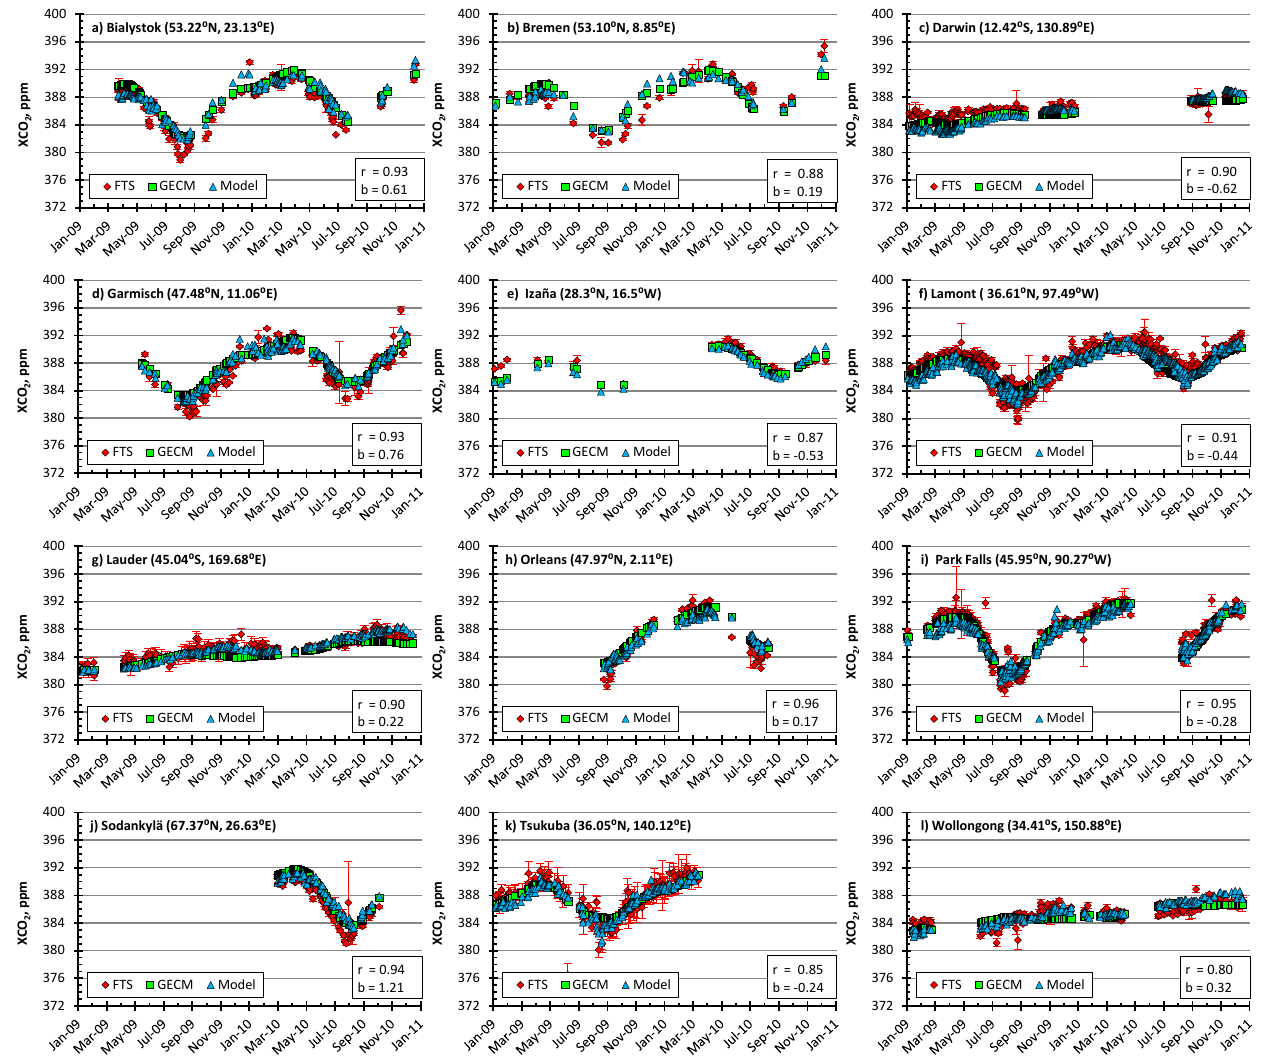
Fig. 12. Time series of XCO 2 measured by FTS, modelled by NIES TM and derived from a 3-D CO 2 climatology GECM for the period January 2009 to February 2011, for the following stations: (a) Bialystok (Poland, 53.22 ◦ N, 23.13 ◦ E); (b) Bremen (Germany, 53.10 ◦ N, 8.85 ◦ E); (c) Darwin (Australia, 12.42 ◦ S, 130.89 ◦ E); (d) Garmisch (Germany, 47.48 ◦ N, 11.06 ◦ E); (e) Iza ˜ na (Spain, 28.30 ◦ N, 16.50 ◦ W); (f) Lamont (USA, 36.6 ◦ N, 97.49 ◦ W); (g) Lauder (New Zealand, 45.04 ◦ S, 169.68 ◦ E); (h) Orleans (France, 47.97 ◦ N, 2.11 ◦ E); (i) Park Falls (USA, 45.95 ◦ N, 90.27 ◦ W); (j) Sodankyl¨a (Finland, 67.37 ◦ N, 26.63 ◦ E); (k) Tsukuba (Japan, 36.05 ◦ N, 140.12 ◦ E); and (l) Wollongong (Australia, 34.41 ◦ S, 150.88 ◦ E). The “error” for each symbol is a combination of the spread due to weighted averaging within the 13:00 ± 1h local time interval and observation